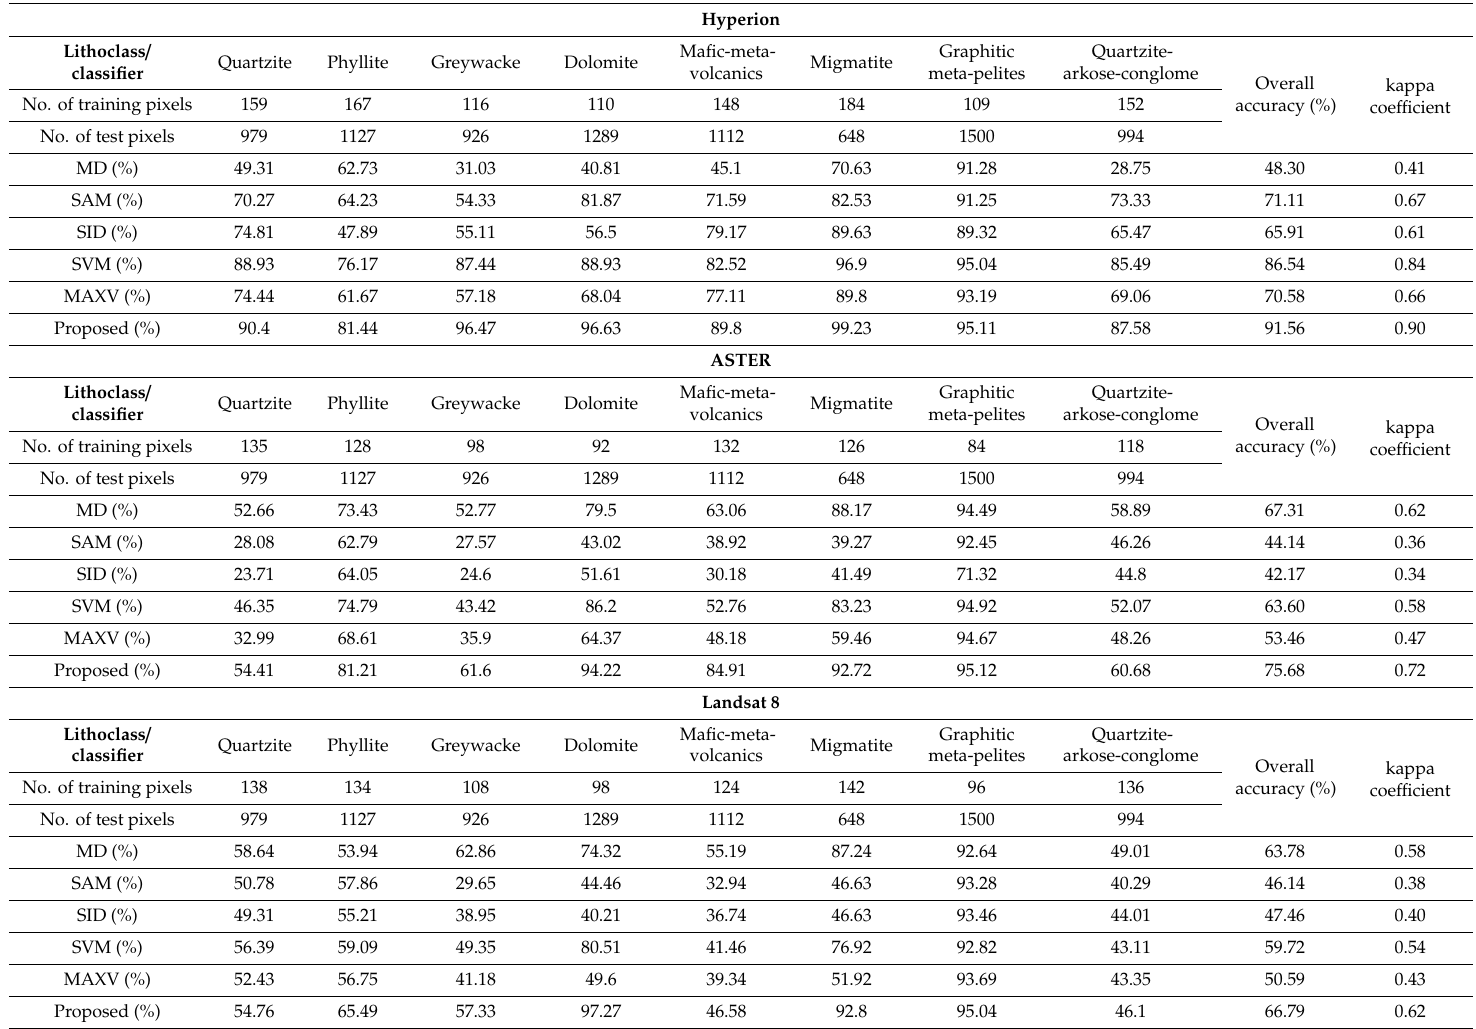
Table 1. ( a ) Classification accuracy assessment. ( b ) Cross-validation overall accuracy (%) for classification accuracy